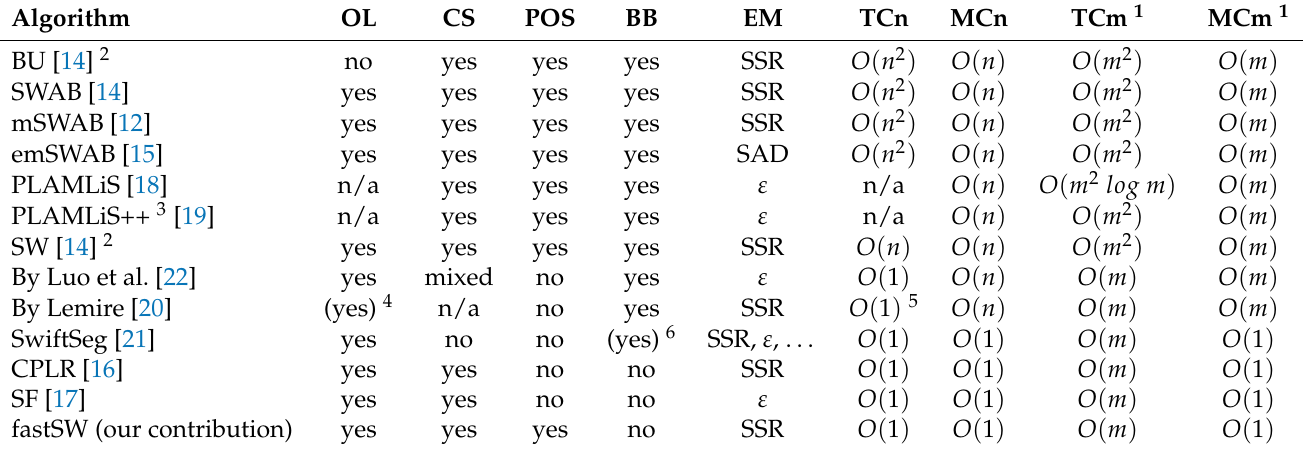
Table 1. Comparison of state-of-the-art PLA algorithms, with OL denoting online applicability, CS the ability to produce connected segments, POS the preservation of original samples, BB the necessity of a buffer, EM the error metric, TCn the time complexity for processing a single sample w.r.t. the segment length n , MCn the memory complexity for processing a single sample w.r.t. segment length n , TCm the time complexity for processing an entire sequence w.r.t. to its length m , MCm the memory complexity for processing an entire sequence w.r.t. to its length m , SSR the sum of squared residuals error of a segment, SAD the sum of absolute deviations of a segment, and ε denoting an absolute residual error per